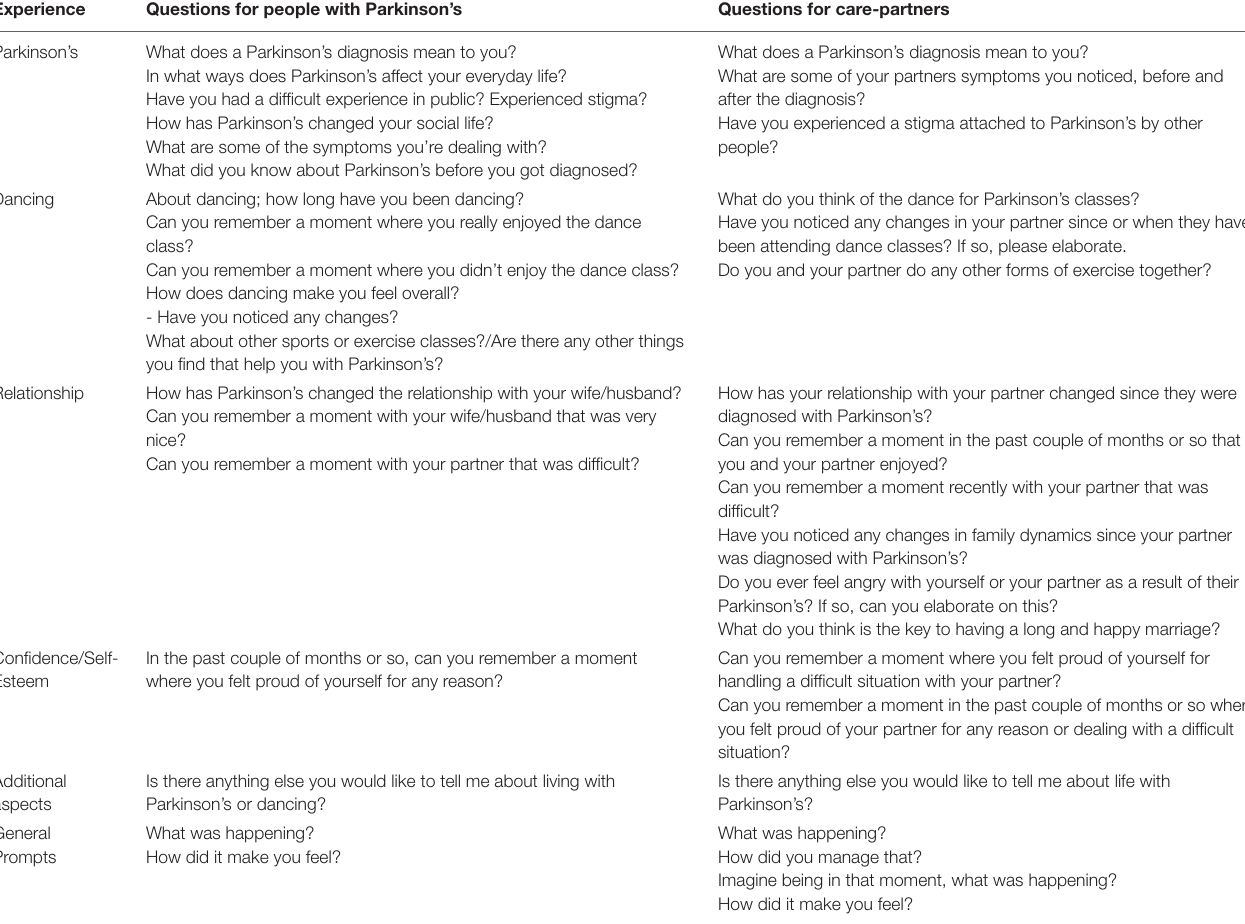
TABLE 1 | Sample interview questions and